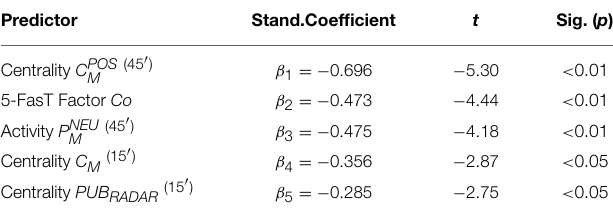
TABLE 9 | Predictors coefficients of opinion shift best model.